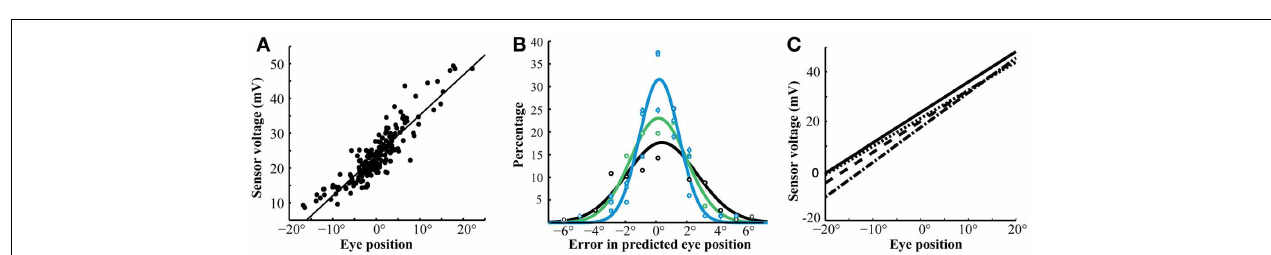
FIGURE 4 | Sensor calibration. (A) Linear correlation of magnetic sensor voltage with optically derived eye position ( r 2 = 0 . 88, p < 0 . 001). This linearity extended over a wide range of eye positions. The data are from the left eye during a single session. (B) Differences between predicted eye positions, derived from calibrated magnetic sensor voltages, and optically recorded eye positions. The different colors are data from different birds. The error in the predictions was under 2 ◦ in greater than 75% of instances and